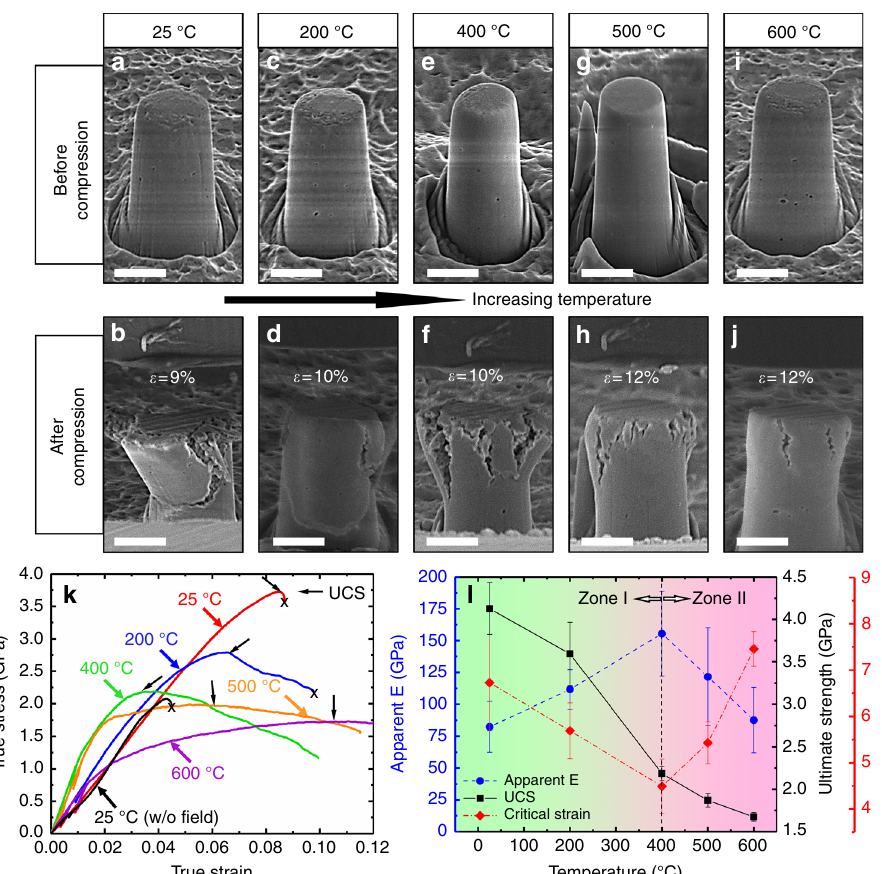
Fig. 3 SEM images of the fl ash-sintered 3YSZ micropillars before and after compression tests from 25 to 600 °C and corresponding mechanical properties. a – d When tested at 200 °C and below, the pillar fractured in a brittle manner (into two major sections) at very large true strain. Scale bar, 2 μ m. e – j When tested at 400 – 600 °C, multiple cracks formed and propagated slowly into the pillars, leading to formation of the cauli fl ower type of pillar tops. At 600 °C, crack density and propagation distance were substantially reduced. Scale bar, 2 μ m. k Corresponding true stress – strain curves of pillars tested at different temperatures. Black arrows indicate the ultimate compressive strength (UCS) of the pillars. Partial unloadings at 0.5 and 1% strains were performed to investigate the apparent elastic moduli of pillars tested at different temperatures. A stress – strain curve for 3YSZ sintered without the electrical fi eld is shown as reference. l Ultimate compressive strength (UCS) decreases monotonically with increasing test temperature. The elastic modulus increases with test temperature up to 400 °C and decreases thereafter. Meanwhile, the critical strain at which the fi rst crack nucleates decreases with temperature to a minimum of 4.5% at 400 °C and increases thereafter to 7.5% when tested at 600 °C. 400 °C is the onset temperature where a different inelastic deformation mechanism begins to operate. Zone 1 represents phase transformation toughening from room temperature to 400°C. Zone 2 corresponds